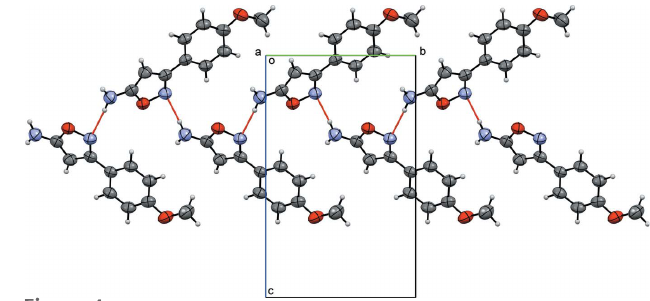
Figure 3 A view along the a -axis direction of the crystal packing of (I) with hydrogen bonds shown as red dashed lines.